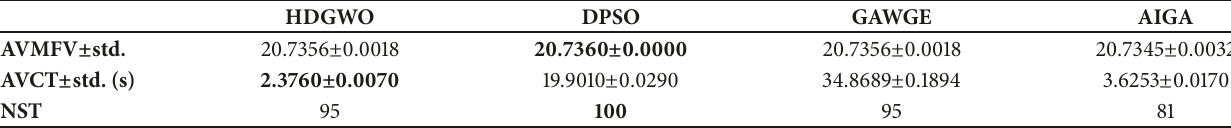
Figure 6: The running result of the global solver of Lingo 11.0. Table 4: Three statistical indicators: the AVMFV, the AVCT, and the